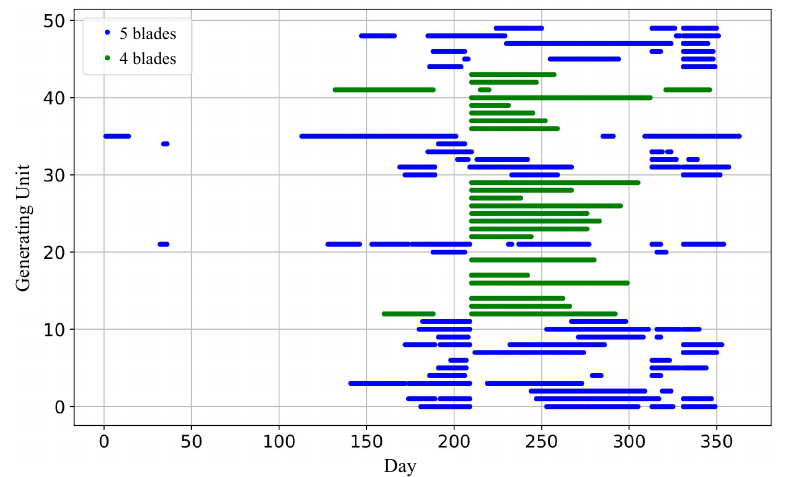
Figure 7. Optimized Maintenance